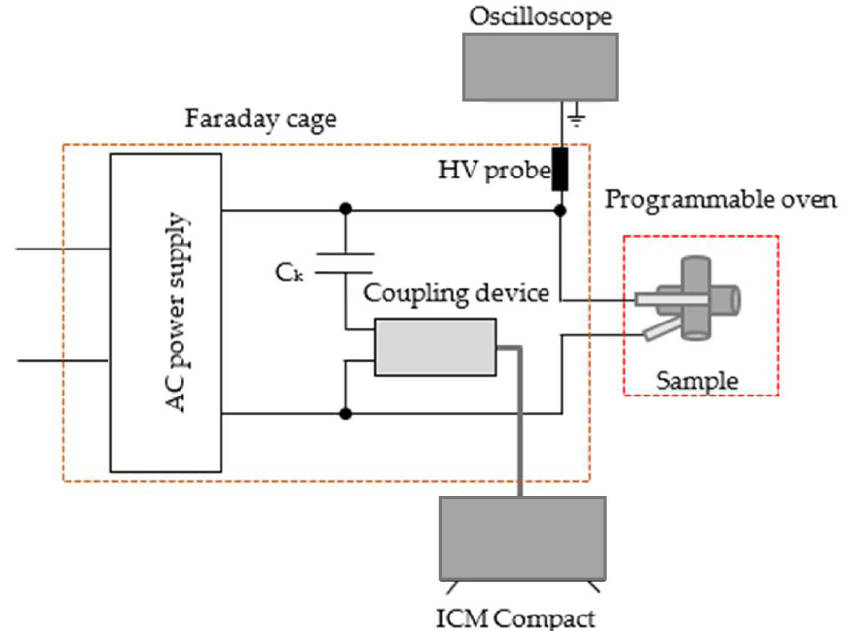
Figure 4. Partial discharge inception voltage measurement system.